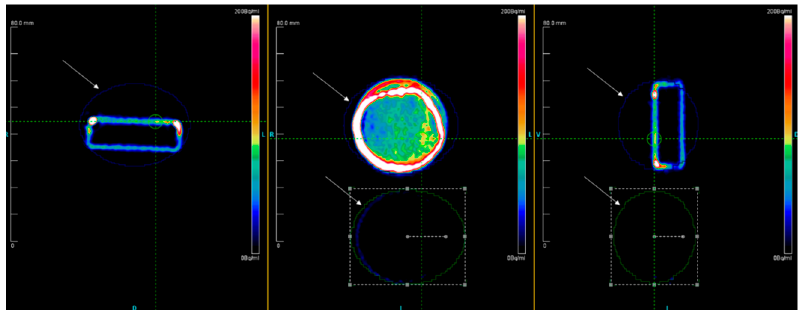
Figure 1. Exemplary µ -PET image of two dishes of one donor. Upper row of the dish was treated using osteogenic medium, while the lower row the dish was treated with control media. Blue and green outlines (indicated by white arrows) defining the regions of interest around the two dishes in axial, coronary and sagittal views.